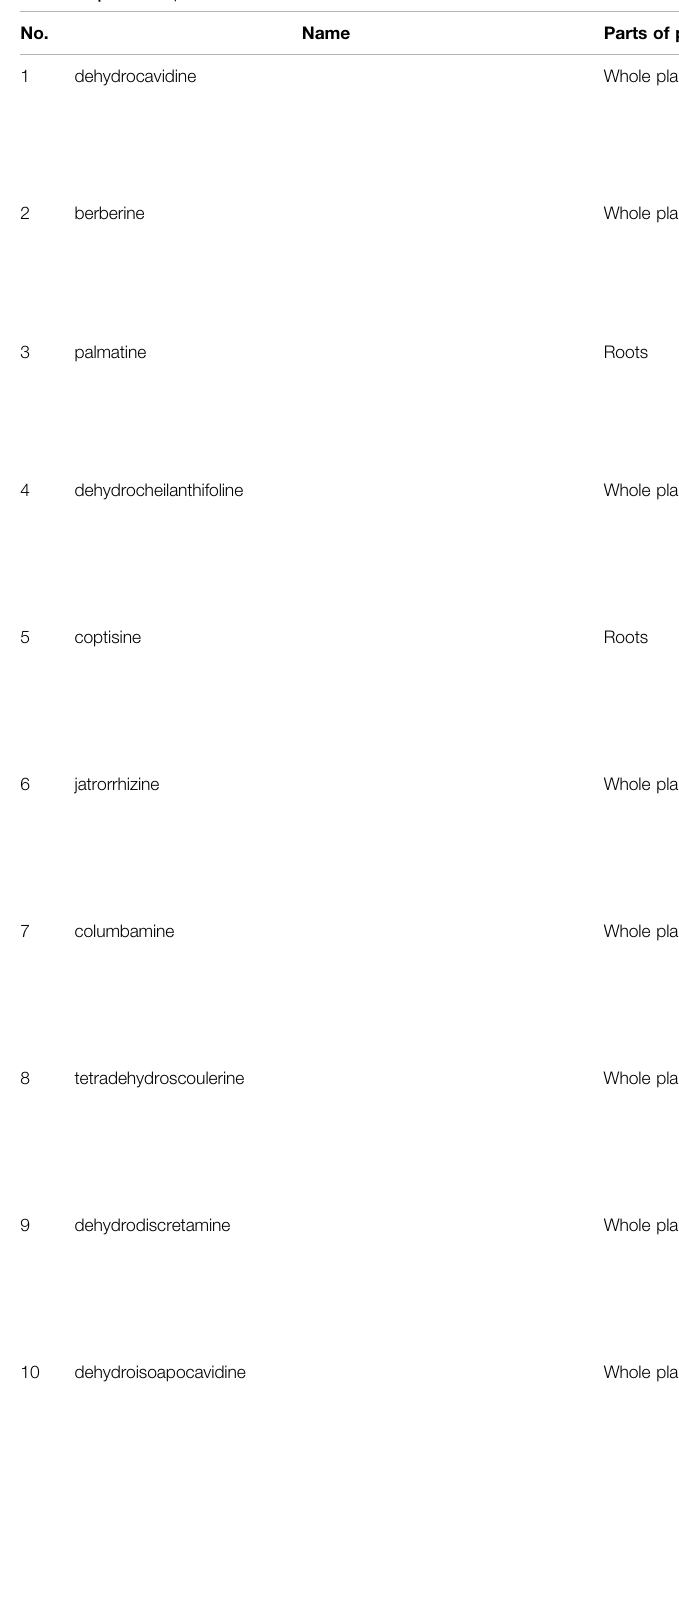
TABLE 1 | The compounds isolated from